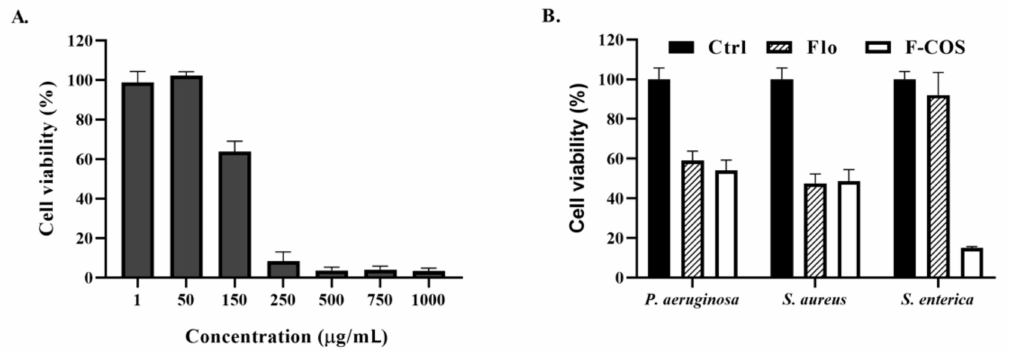
Figure 6. F-COS showed Broad-spectrum antibacterial activities. The antibacterial activity of serial dilutions of F-COS against vegetative-growth Streptococcus hyovaginalis cells ( A ). The anti-biofilm activity of F-COS and florfenicol (Flo) was tested against the mature biofilm of Pseudomonas aeruginosa, Staphylococcus aureus, and Salmonella enterica at a concentration of 250 µ g / mL ( B ). Data are represented as means ± SD ( n = 6) of cell viability compared to the untreated